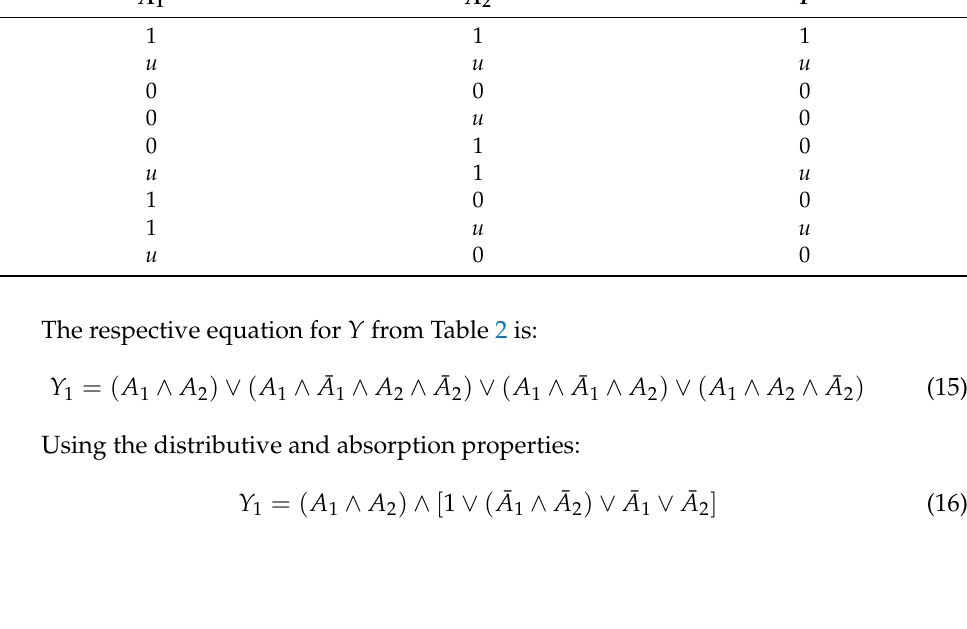
Table 1. Example of terms use for elaborate DNF in